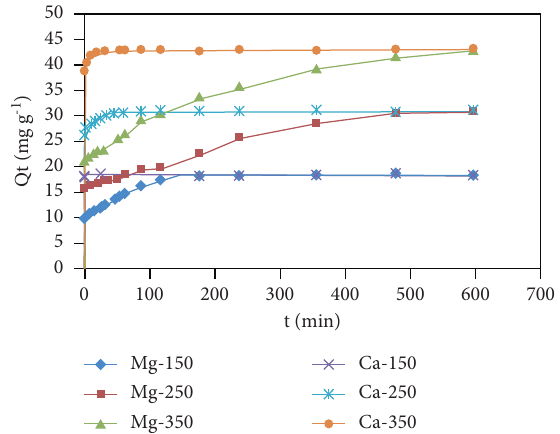
Figure 13: The Ca 2+ and Mg 2+ competitive exchange data with different initial concentration adopted from the work of Gha- damnan et al.